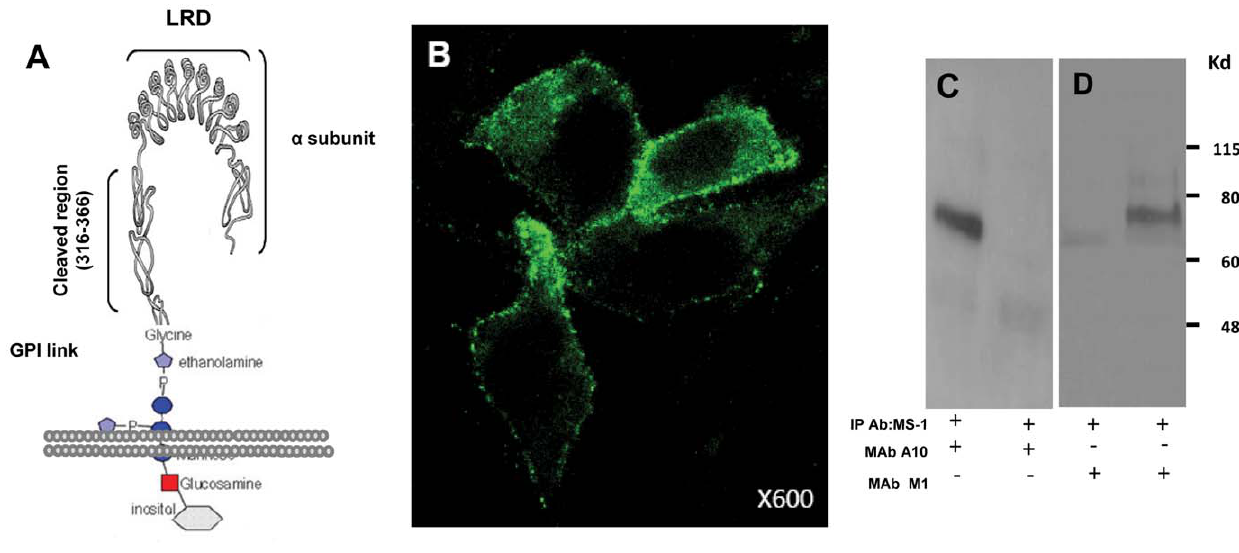
Figure 2. TSHR ectodomain linked to GPI as a source of antigen. Panel A - The source of the native antigen for epitope protection studies was the entire TSHR ectodomain (ECD) protein which was anchored to the plasma membrane via a GPI linker. This link could be cleaved by phospholipase C treatment to obtain large amounts of purified receptor ectodomain. Panel B - Surface expression of the TSHR-GPI construct on CHO cells is illustrated by staining with TSHR-mAb M1 directly conjugated to Alexa 488. Panel C - Immunoprecipitation of solubilized receptors from total membrane preparations obtained from GPI-TSHR-ECD cells precipitated using MS-1 (2 ug/ml) (lane 1) and probed with an antibody to the N- terminus of the receptor (A10). A specific band corresponding to 74KD protein was observed in lane 1 whereas no immunoprecipitation was observed with MS-1 using membranes prepared from untransfected CHO cells (lane 2) and probed with an antibody directed to amino terminus of receptor (A10, residues 22–41). Panel D - PI-PLC digest obtained from GPI-TSHR-ECD cells immunoprecipitated with MS-1 (2 ug/ml) (lane 2) and from GPI-TSHR-ECD cells untreated with PI-PLC (lane 1). A specific band corresponding to a 74KD protein was observed in lane 2 compared to a faint lower weight band obtained with vehicle alone (lane 1). The faint band maybe is the result of CHO-TSHR cell breakdown that resulted in some binding of TSHR-mAb.